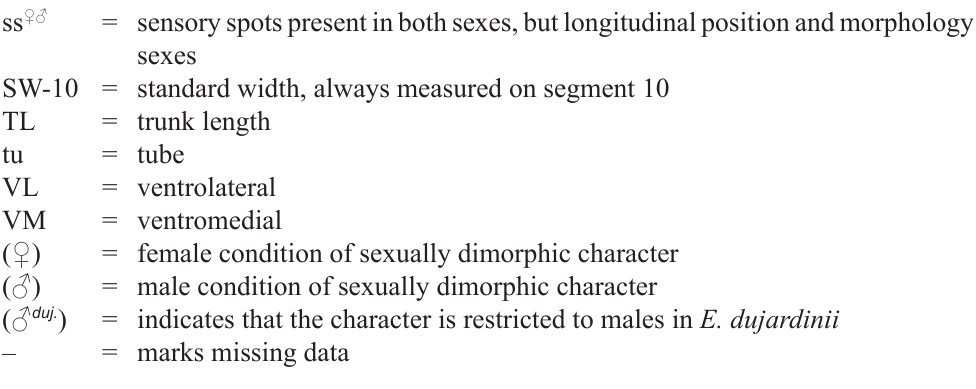
The following abbreviations are used in figure